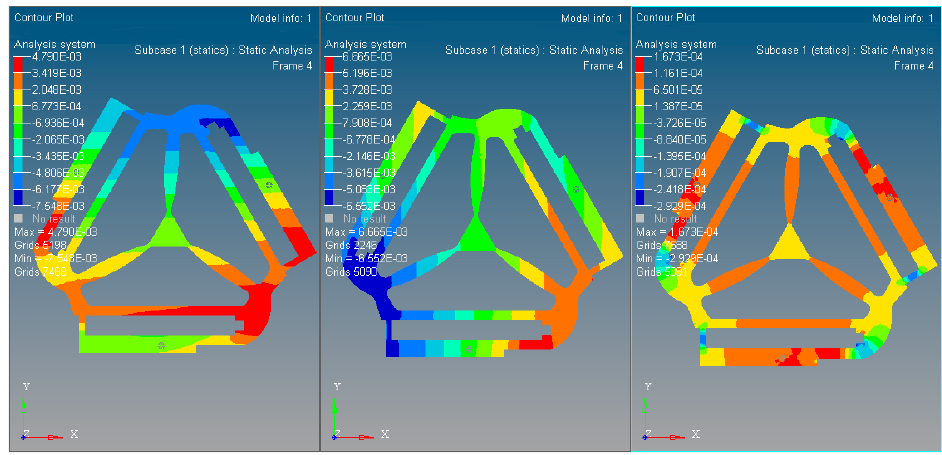
Figure 19. The kinematostatic characteristics simulation results by Hyperworks ® .